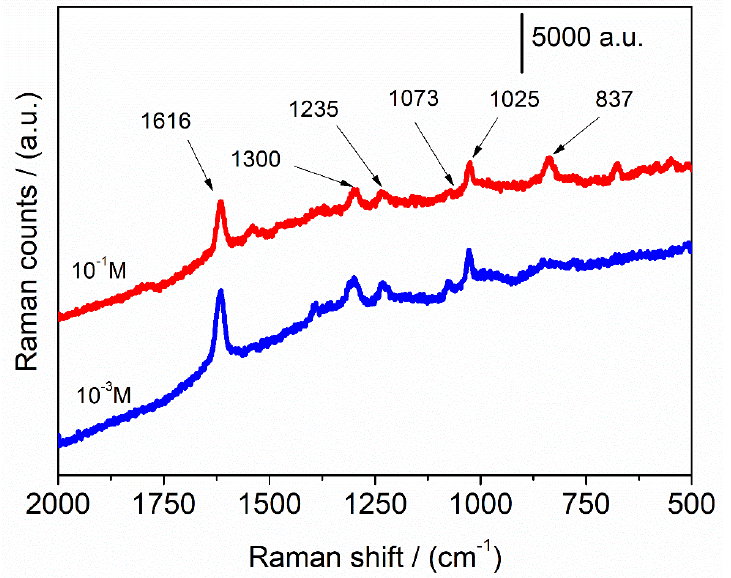
Figure 7. The highest SERS spectra (average of 10 accumulations) of ascorbic acid at different concentrations on 3 min A-NPG. Spectra were acquired randomly on the surface.